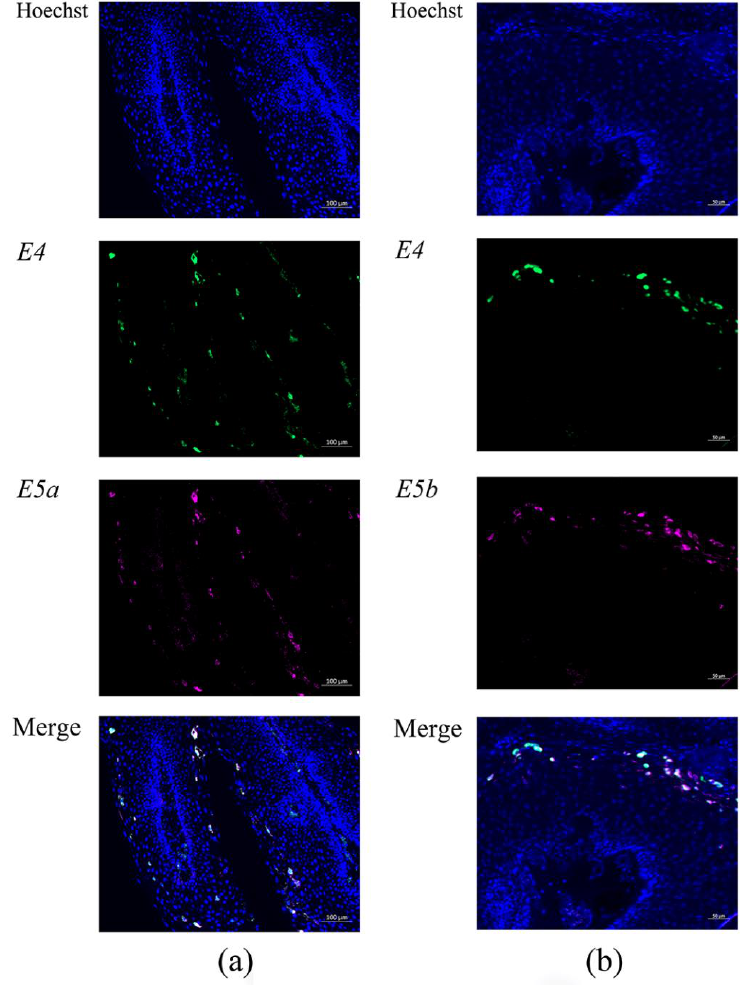
Figure 6. E4 and E5a , and E4 and E5b expression detected by double fluorescence RNA-ISH. ( a ) Double staining of E4 and E5a in LP (bar = 100 μm). ( b ) E4 and E5b in LP (bar = 50 μm). E4 and E5a and E4 and E5b mRNAs were co-expressed in the same LP